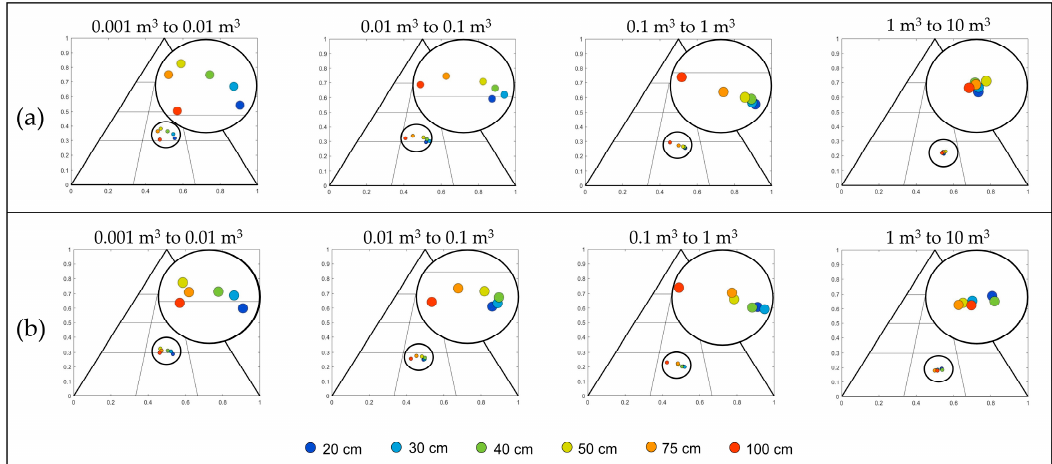
Figure 15. Sneed and Folk ternary plots showing the average shape of the extracted rockfalls for each projection diameter. Average shapes are plotted with color corresponding to the projection diameter. ( a ) The average sandy siltstone rockfall shape; ( b ) The average shale rockfall shape. The rockfalls were sorted into bins of differing orders of magnitude, considering that interaction of different joint sets is responsible for differing rockfall magnitudes and shapes.